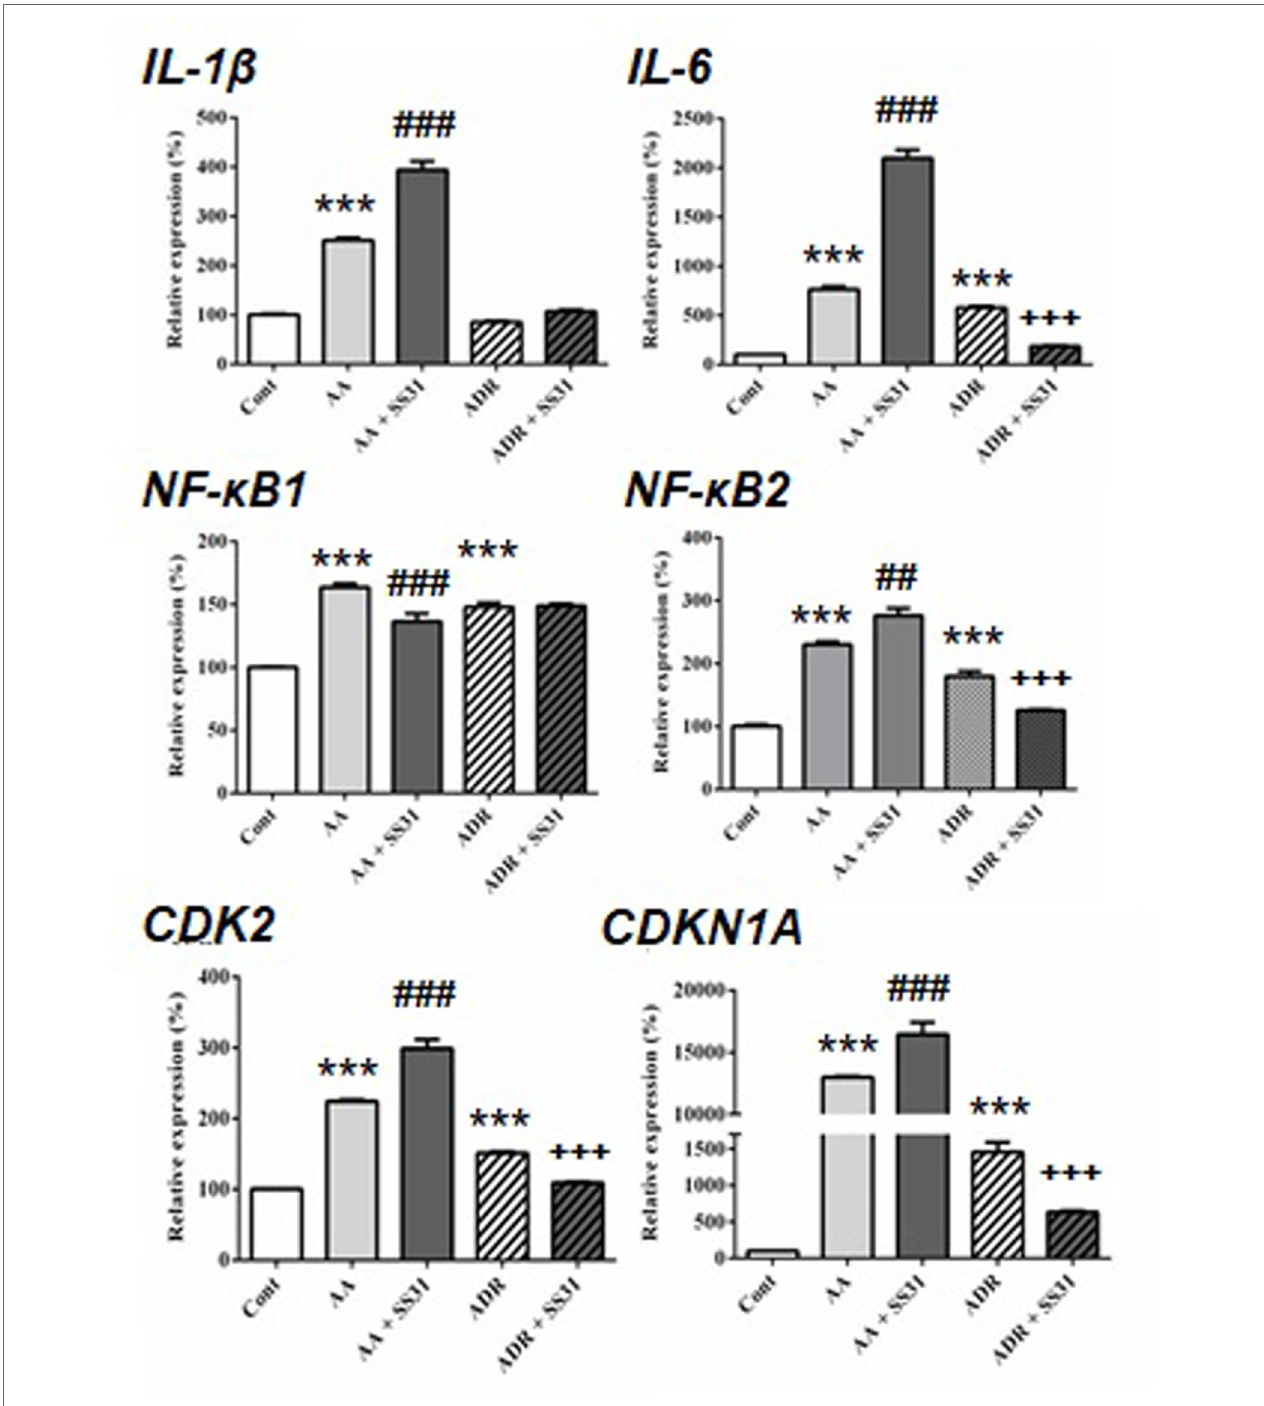
FIGURE 3 | Expression of acute pro-inflammatory pathway-responsive genes in the kidneys of mice exposed to aristolochic acid or adriamycin, without or with SS-31. After 7 days of administration of either aristolochic acid (AA) or adriamycin (ADR), alone or together with SS-31 (+SS31), the animals (n = 5 mice per experimental group) were sacrificed and their kidneys retrieved for the determination by qRT-PCR of the mRNA levels of genes of components of acute inflammatory pathways. Healthy wild-type BALB/c male mice were used as controls (Cont). The levels of expression of the mRNAs for interleukin (IL)- β , IL-6, nuclear factor kappa-light-chain-enhancer of activated B cells (NF- κ B)1, NF- κ B2 and cyclin-dependent kinases (CDK2 and CDKN1A) were quantified by qRT-PCR. Results were averaged for all animals in each experimental group and are presented as % of changes in the mRNA levels in the treated animals versus control animals ± sem.*: AA or ADR compared to Cont; # : AA + SS-31 or + : ADR + SS-31 compared to AA or ADR alone, respectively. (*p < 0.05; **p < 0.01; ***p < 0.001; applies to all